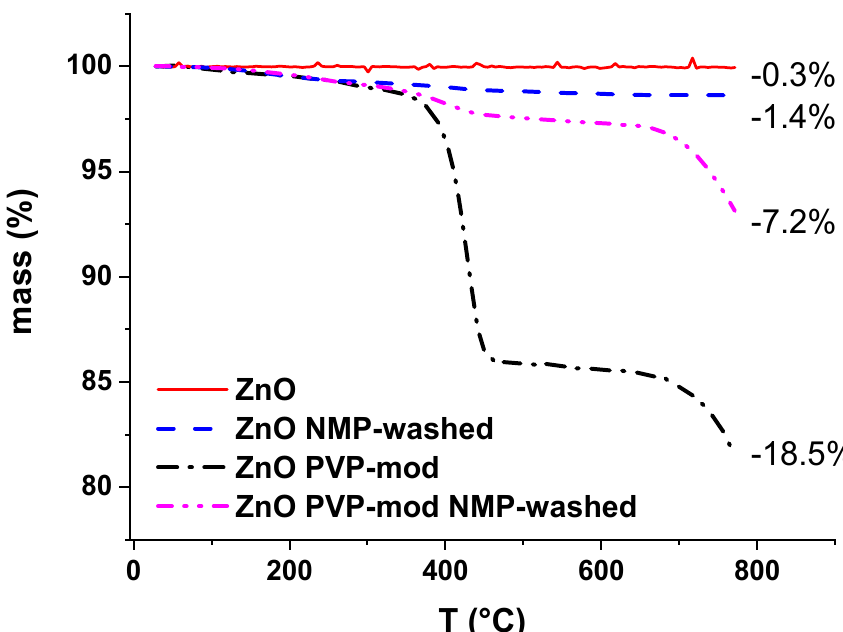
Figure 6. Thermogravimetric analysis of ZnO nanoparticles before and after modification with NMP as well as after washing with NMP for 2 days at 60 °C. Final relative mass difference compared to initial state is also indicated.